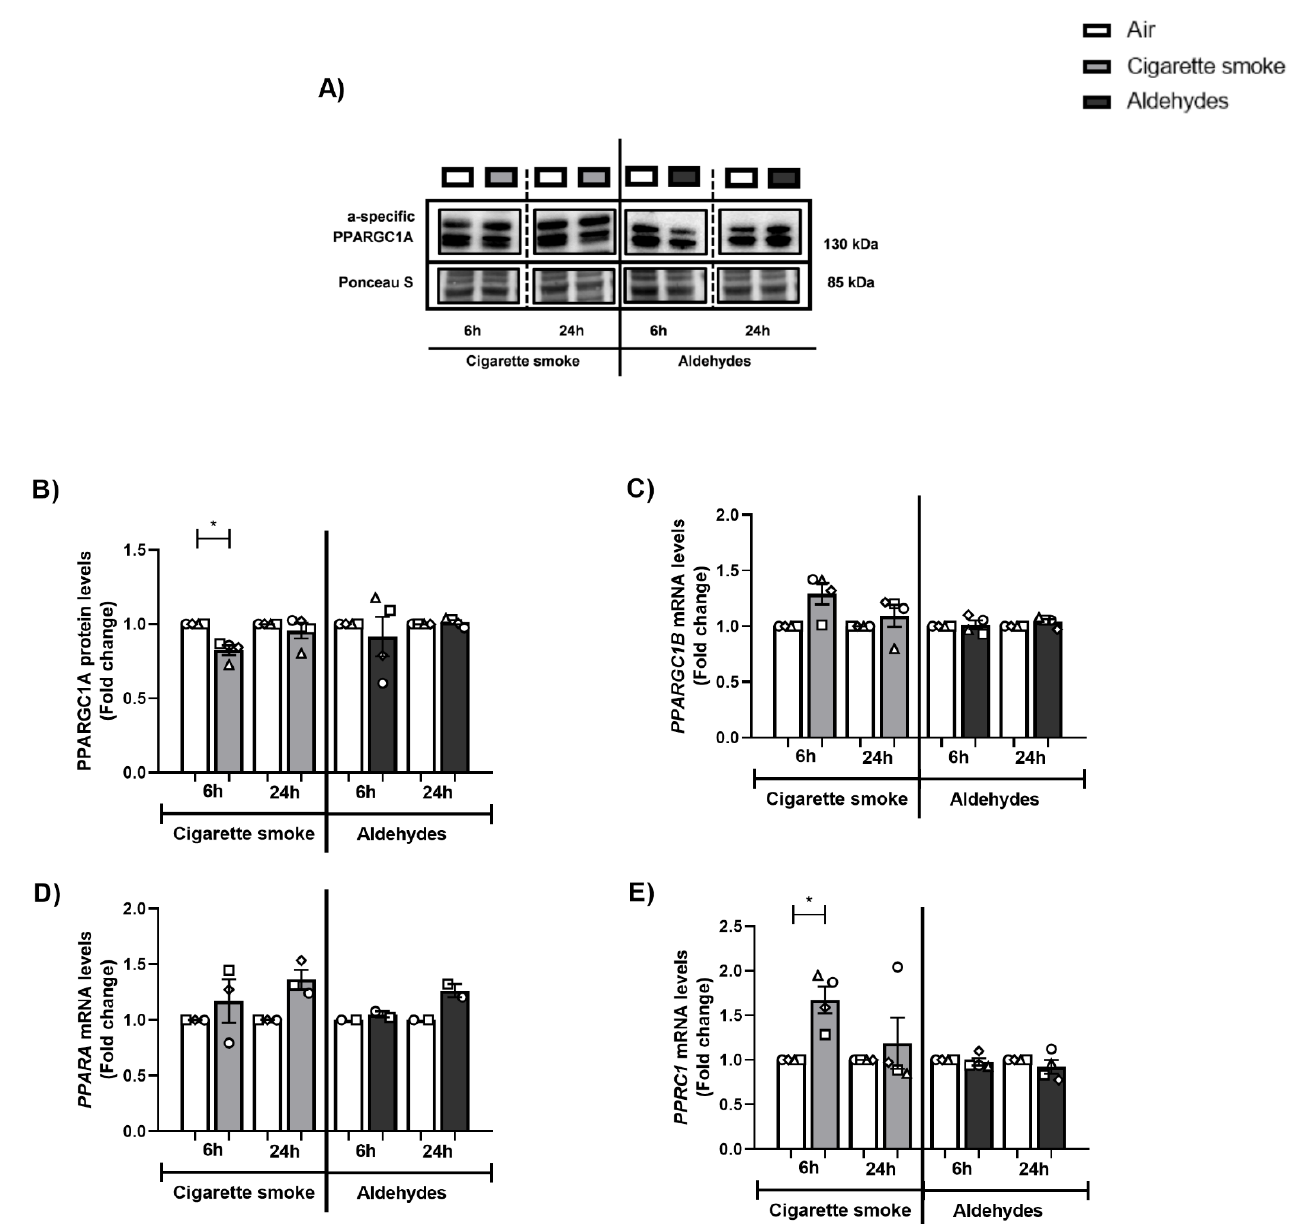
Figure 5. Altered abundance of constituents controlling mitochondrial biogenesis following CS exposure. Differentiated human primary bronchial epithelial cells (PBEC) from non-COPD subjects ( n = 3–4 donors) were exposed to smoke of one Marlboro Red cigarette (CS), or a mixture of acetalde- hyde, acrolein, and formaldehyde (at concentrations equivalent to one cigarette), or air (control), under a continuous flow system using a puff-like exposure protocol. Following recovery for 6 h or 24 h, whole cell lysates were harvested and ( A , B ) protein levels of PPARGC1A, as well as ( C – E ) transcript levels of PPARGC1 molecules: PPARGC1B , PPARA , PPRC1 were analyzed. Representative Western blot images are shown for one replicate of one donor per experiment, reflective of the changes in all donors as quantified in the corresponding graph. Data are presented as mean fold change compared to air control ± s.e.m. The mean values of biological triplicates for each independent donor are represented by open circles, triangles, squares, or diamonds. Statistical differences between CS vs. air and the mixture of aldehydes vs. air were tested using a two-tailed paired parametric t -test. Statistical significance is indicated as * p < 0.05 vs. air (control).